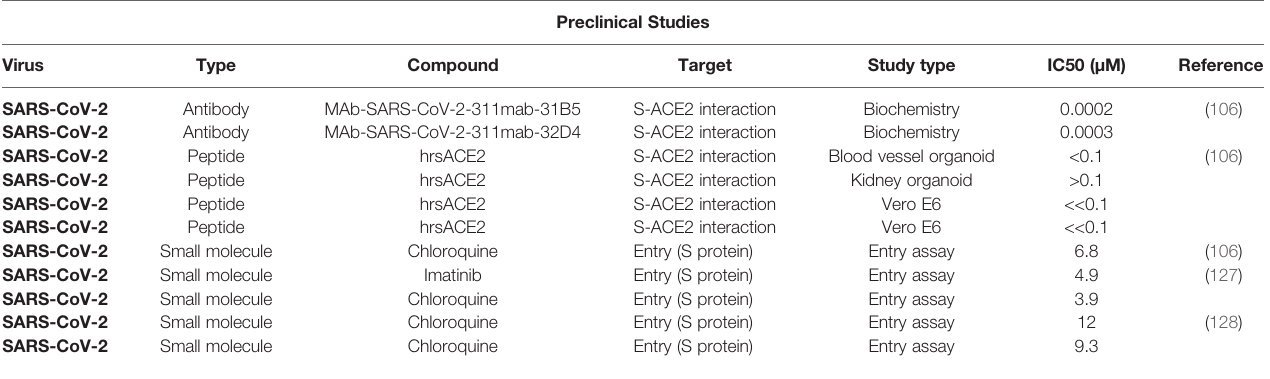
TABLE 3 | Promising therapeutics targeting SARS-CoV-2 Spike